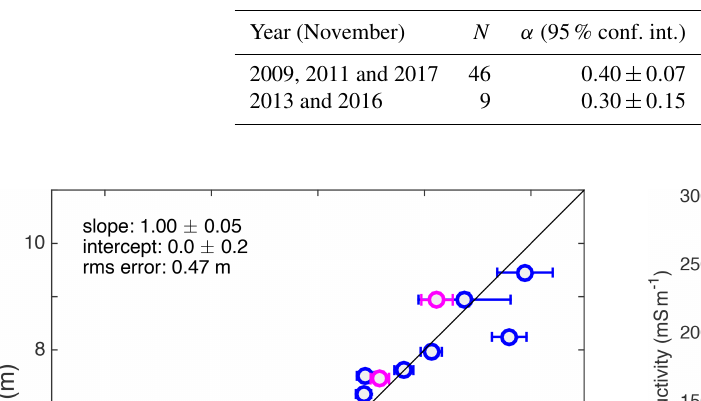
Table 1. Summary of drill-hole calibration results showing the number of drill-hole measurements N , derived scaling factor α (Eq. 5c), SIPL conductivity σ SIPL , and solid fraction β . Data from several years with similar behaviour were pooled to increase the number of data points for more reliable fits.